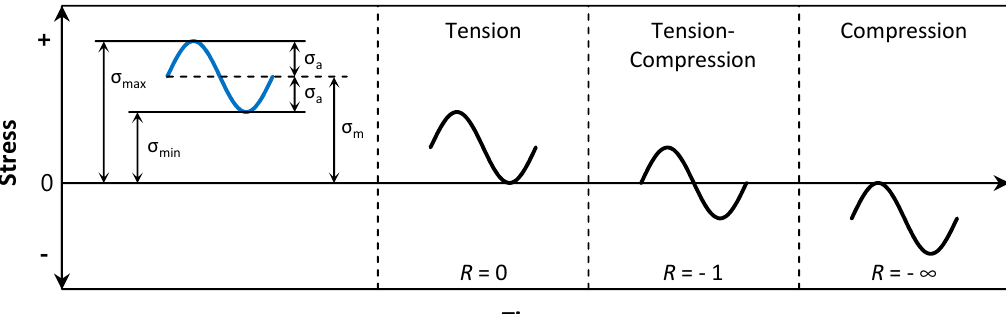
Figure 1. Stress cycles with different stress ratios of R = 0, − 1 and −∞ .